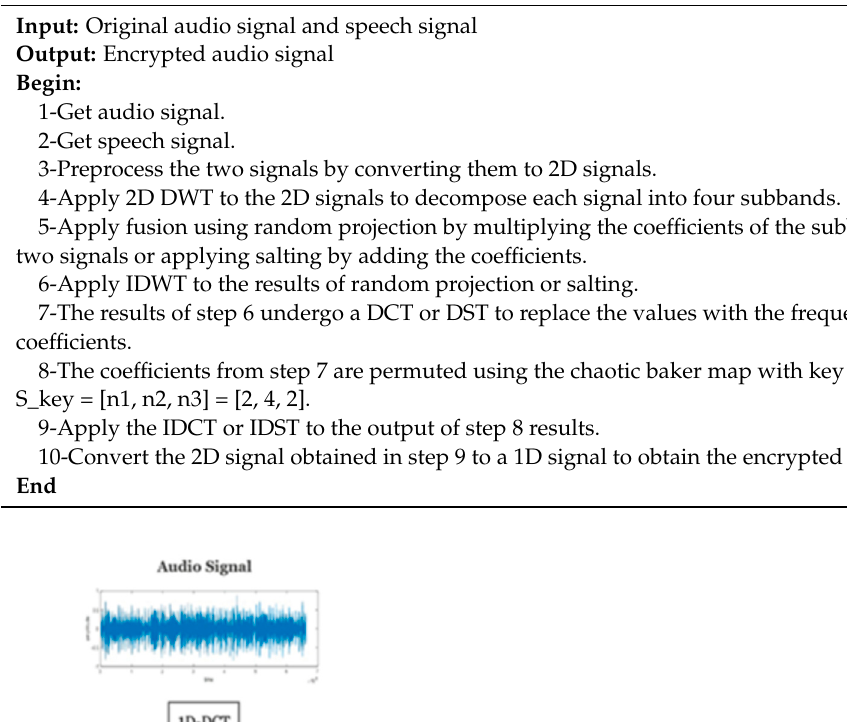
Algorithm 1: Encryption